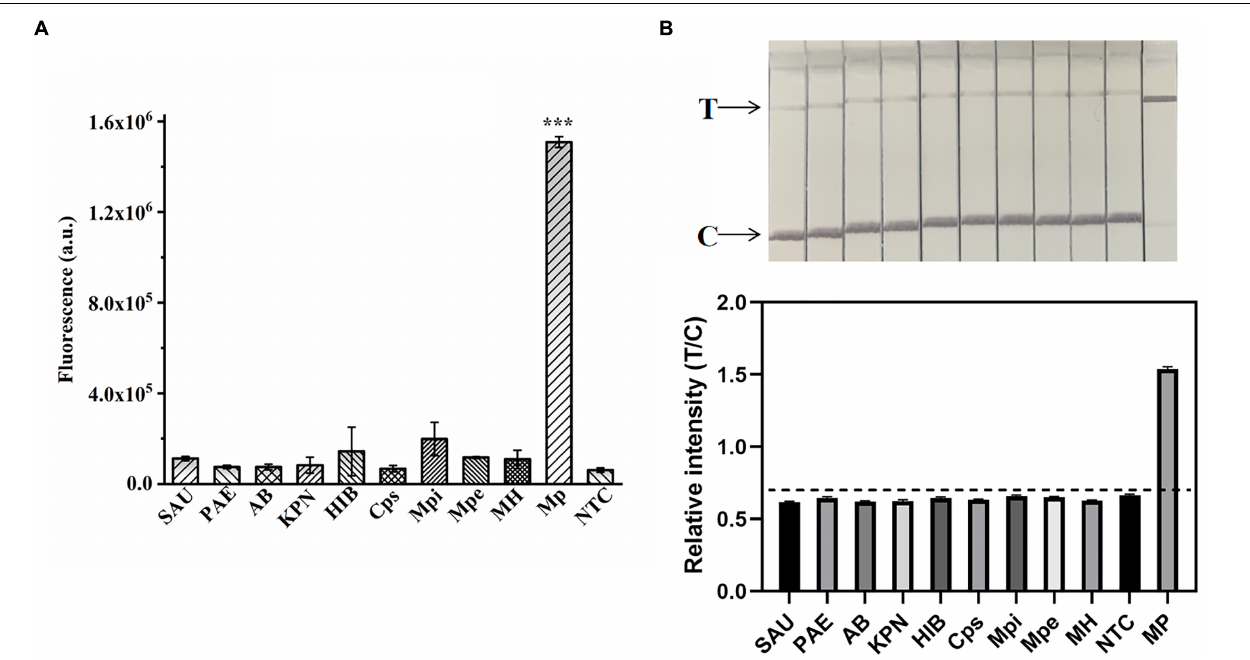
FIGURE 6 | Validation of the specificity of the ERA/CRISPR–Cas12a dual system. Specificity test of the ERA/CRISPR–Cas12a fluorescence system (A) and dipstick system (B) for targeting M. pneumoniae . SAU : Staphylococcus aureus ; PAE : Pseudomonas aeruginosa ; AB : Acinetobacter baumannii ; KPN : Klebsiella pneumoniae ; HIB : Haemophilus influenzae ; Cps : Chlamydia psittaci ; Mpi : Mycoplasma pirum ; MPe : Mycoplasma penetrans ; MH : Mycoplasma hominis . The black horizontal dashed line in the gray scan indicates the cutoff value set based on T/C values of the negative control. Error bars in panels represent the mean ± SD, where n = 3 replicates. *** P <